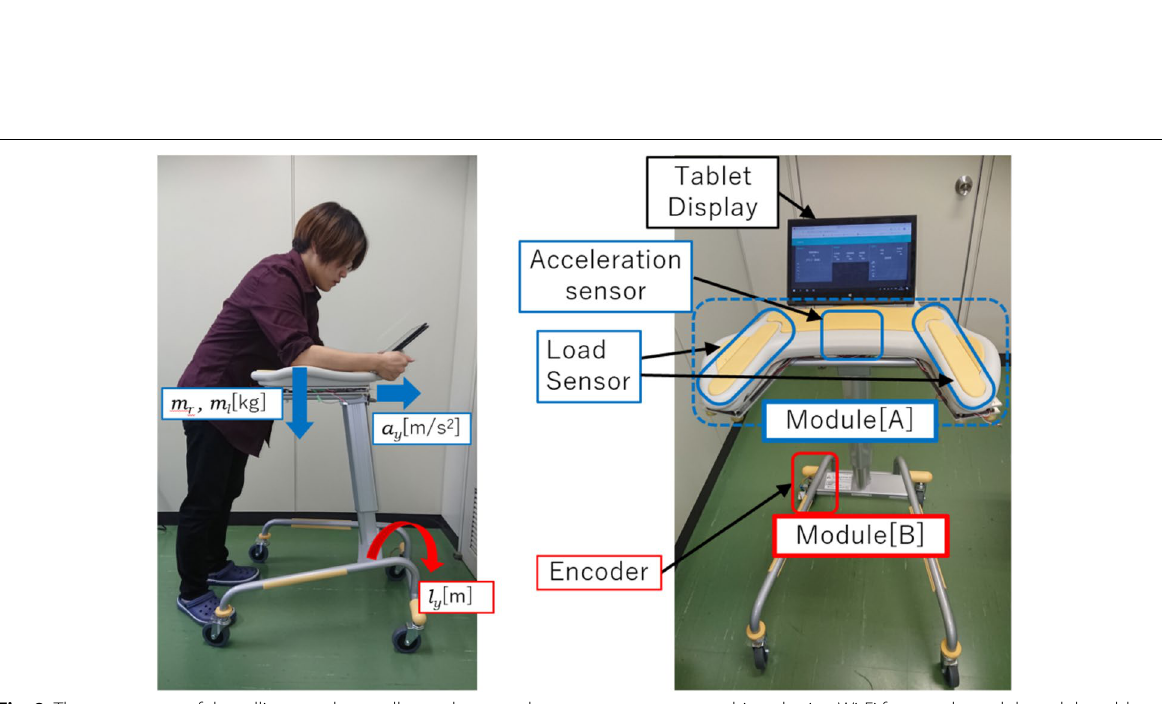
Fig. 8 The appearance of the rolling stand-up walker and sensor placement—access was achieved using Wi-Fi from each module and the tablet terminal to realize system visualization of the exercise